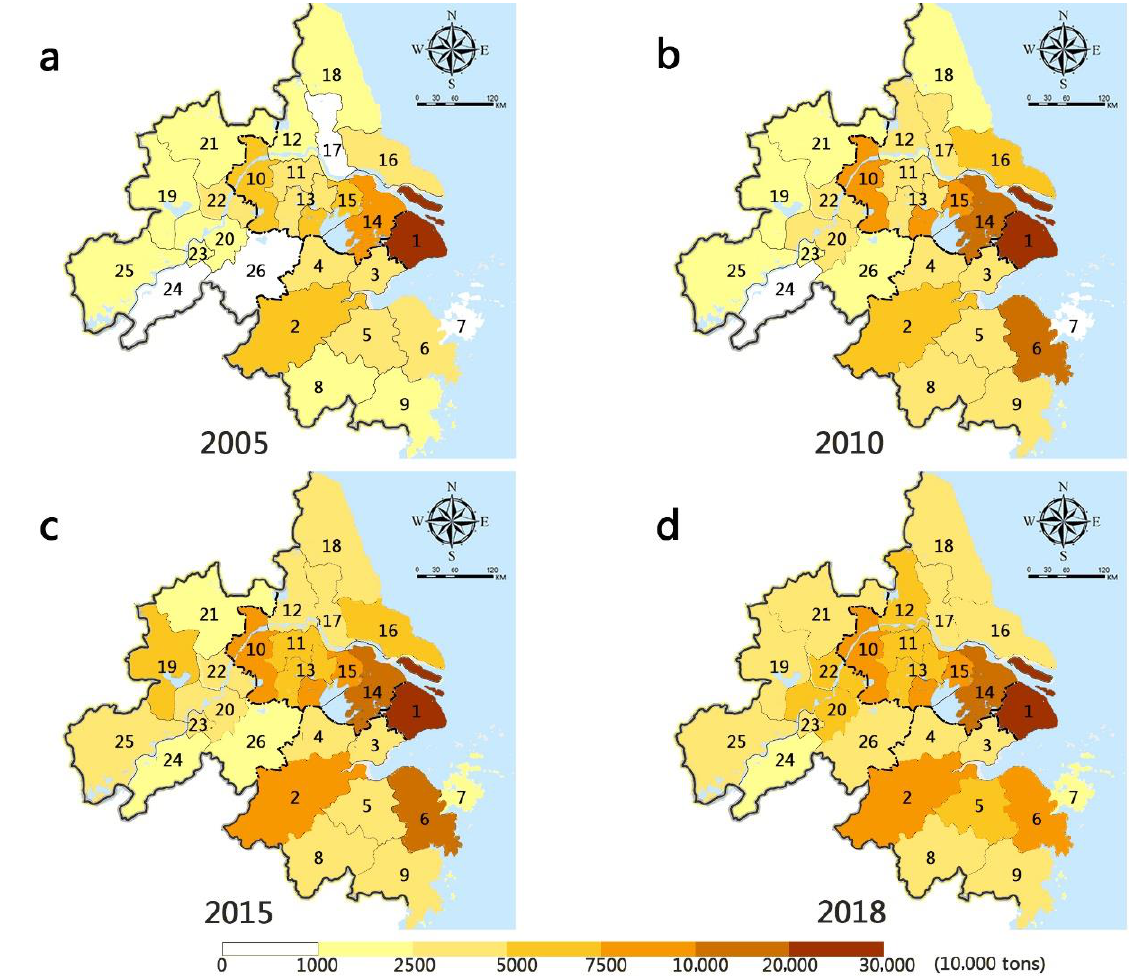
Figure 4. CO 2 emission intensity of the YRDUA’s cities : ( a ) in 2005; ( b ) in 2010; ( c ) in 2015; ( d ) in 2018.